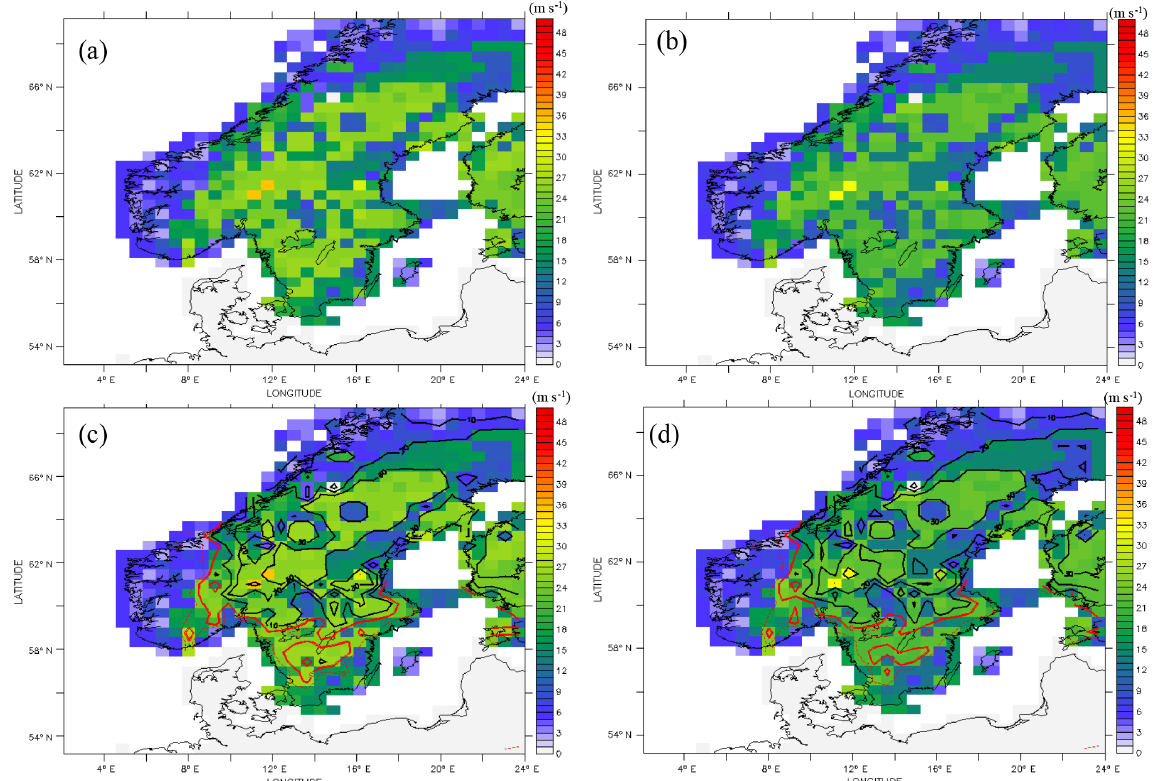
Figure 4. The ORCHIDEE-CAN-calculated lowest critical wind speeds for overturning or stem breakage for forest located near (inner) and away (outer) from a forest edge. When making the display, the critical wind speeds from the three diameter classes and four age groups from Picea species were assessed and the lowest value was compared against the daily maximum wind speed for estimating the damage due to storms. Lowest critical wind speeds in the forest away from a forest edge (outer) (a) , lowest critical wind speeds in the forest near a forest edge (inner) (b) , lowest critical wind speeds overlaid with the difference between maximum daily wind speed and lowest critical wind speed in outer area on 9 January 2005 (c) , and lowest critical wind speeds overlaid with the difference between maximum daily wind speed and lowest critical wind speed in the outer area (d) . The contours show the positive wind speed difference in black and the negative wind speed difference in red. Forests within the red contours are expected to suffer from storm